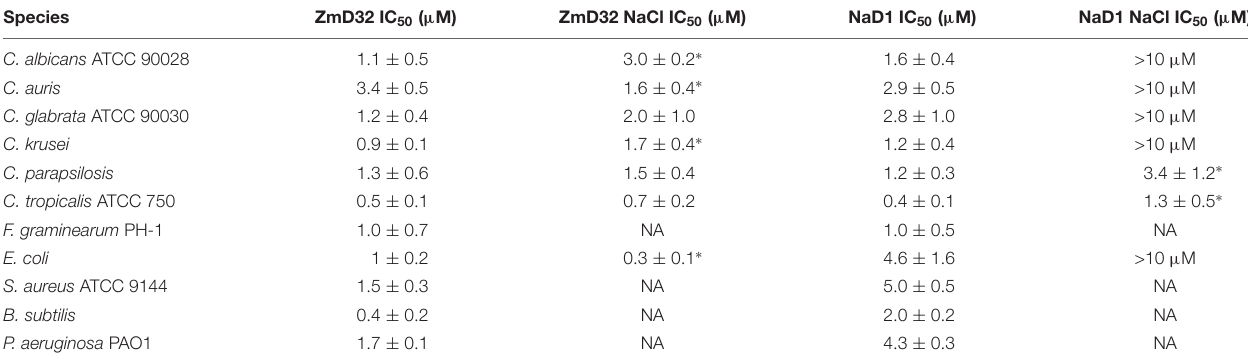
TABLE 1 | Activity of ZmD32 against fungi and bacteria in low salt medium.